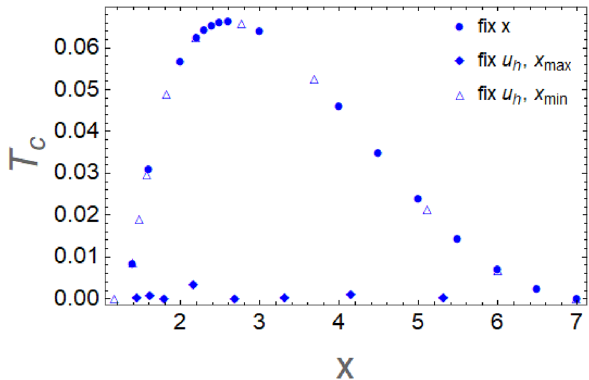
Fig. 9 The dome-shaped region of the superconducting instability. We use two methods to obtain the critical temperature T c as a function of doping parameter x . Here we fix the parameters as M 2 = − 5 / 4 , m = 1 , a = − 10 , b = − 4 / 3 , c = 14 / 3 , n = 1 ,ρ A = 1 ,α = 0 ,ρ B = x and ( 0 , 1